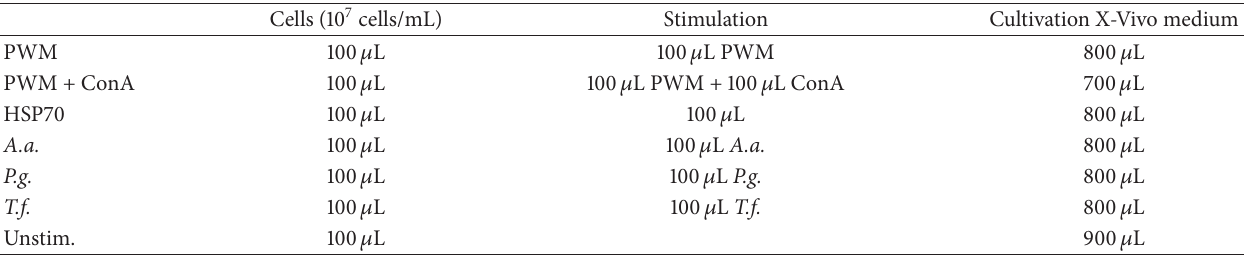
Table 2: Scheme of in vitro stimulation of mononuclear